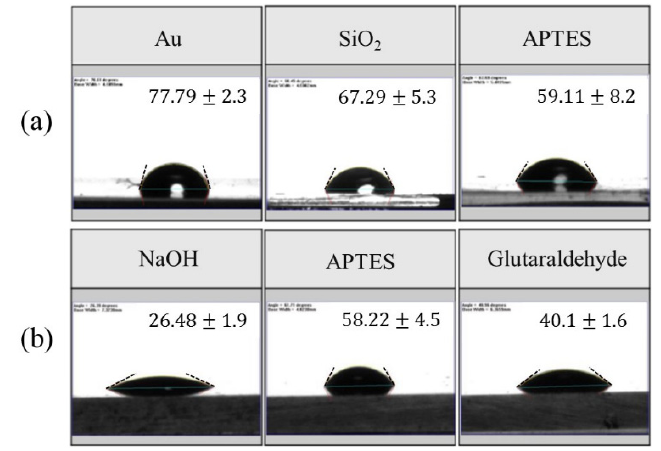
Figure 6. ( a ) Contact angles of Au, SiO 2 layer and APTES film. ( b ) Contact angles of NaOH treatment, APTES film and glutaraldehyde film. Dash line indicates the asymptotic of the contact line.